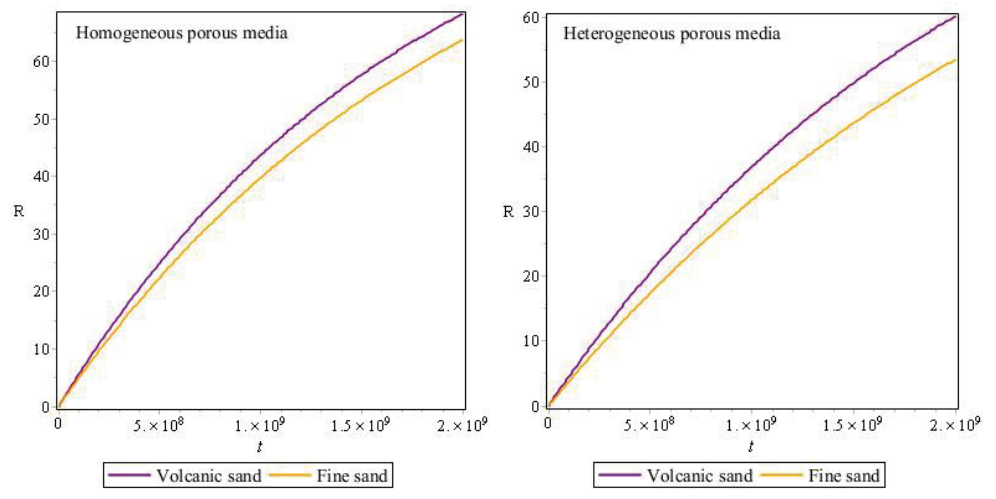
Fig. 10: Comparison of recovery rate for Volcanic sand and Fine sand in Homogeneous and Heterogeneous porous media Table 9: Comparison of Recovery rate for Volcanic Sand and Fine Sand in Fracture Porous Media Recovery Rate Homogeneous porous media Heterogeneous porous media Dimension Time t